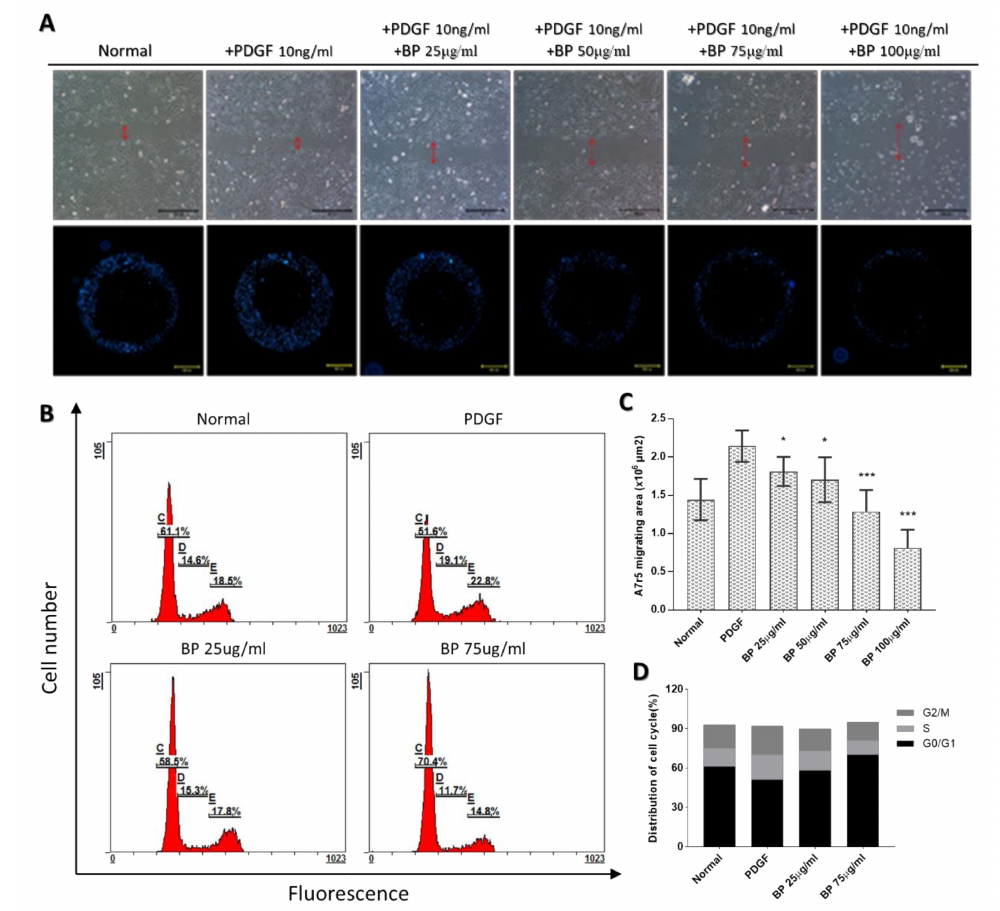
Figure 2. BP inhibits migration and arrests the PDGF-induced A7r5 in the G0 / G1 phase in a dose-dependent manner. ( A ) A wound-healing assay ( upper panel, scale bar = 500 µ m) and Oris system migrating assay ( lower panel, scale bar = 500 µ m) were performed since A7r5 was treated with PDGF (10 ng / mL) and BP (0, 25, 50, 75 and 100 µ g / mL) for 24 h; ( B ) Cell cycle analysis through PI staining and following flow cytometry for the A7r5 after 24 h of PDGF (10 ng / mL) and BP treatment (0, 25 and 75 ug / mL); ( C , D ) Quantification of the Oris system migrating assay and cell cycle analysis. Data are expressed as the mean ± SEM. * p < 0.05, *** p <